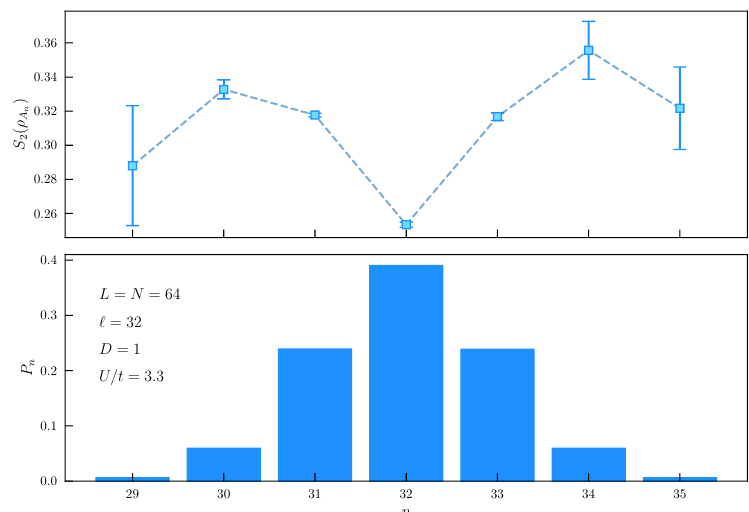
Figure 14: Symmetry-resolved Rényi entanglement entropies as a function of local particle number sector, n . The system is a one-dimensional lattice of N = 64 bosons at unit-filling under an equal spatial bipartition ℓ = 32 near the critical interaction strength U / t = 3.3. The bottom panel shows the local particle number distribution, P , for this n